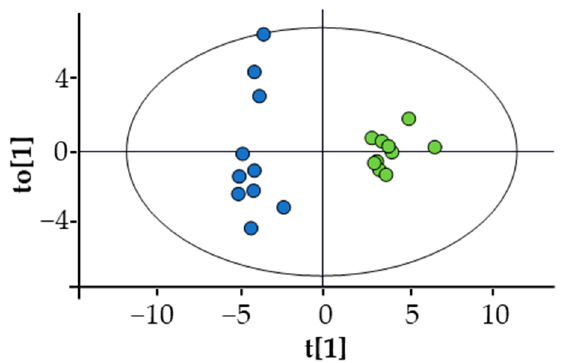
Figure 2. Score plot of the OPLS-DA of TTS (blue dots) vs. CTRL (green dots). Statistical parameters: R 2 X(cum) = 0.413; R 2 Y(cum) = 0.949; Q 2 (cum) = 0.851; CV ANOVA = 4.7 × 10 − 6 . Permutation test was also performed: number of permutations = 100; R 2 intercept = 0.643; Q 2 intercept = − 0.334. None of the permutated models showed higher R 2 or Q 2